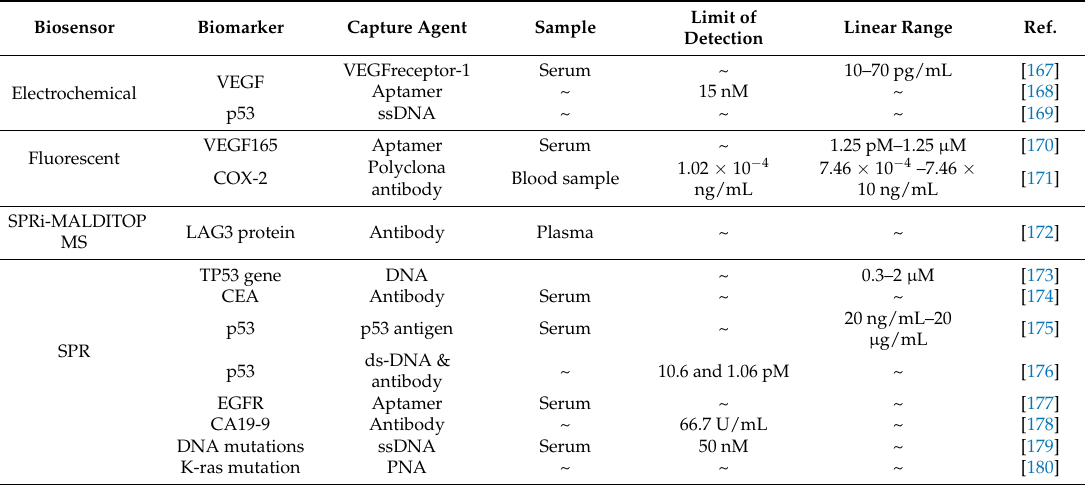
Table 4. Some new developed biosensors for target marker